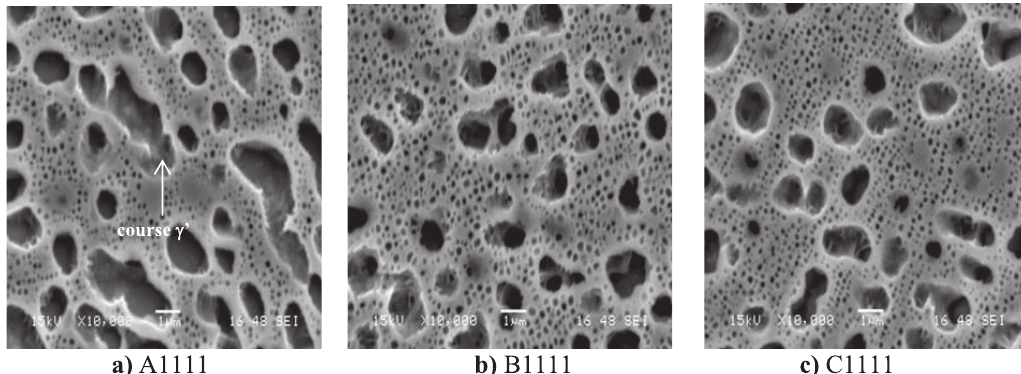
Figure 22. Microstructures of specimens after reheat treatment of Program 12.